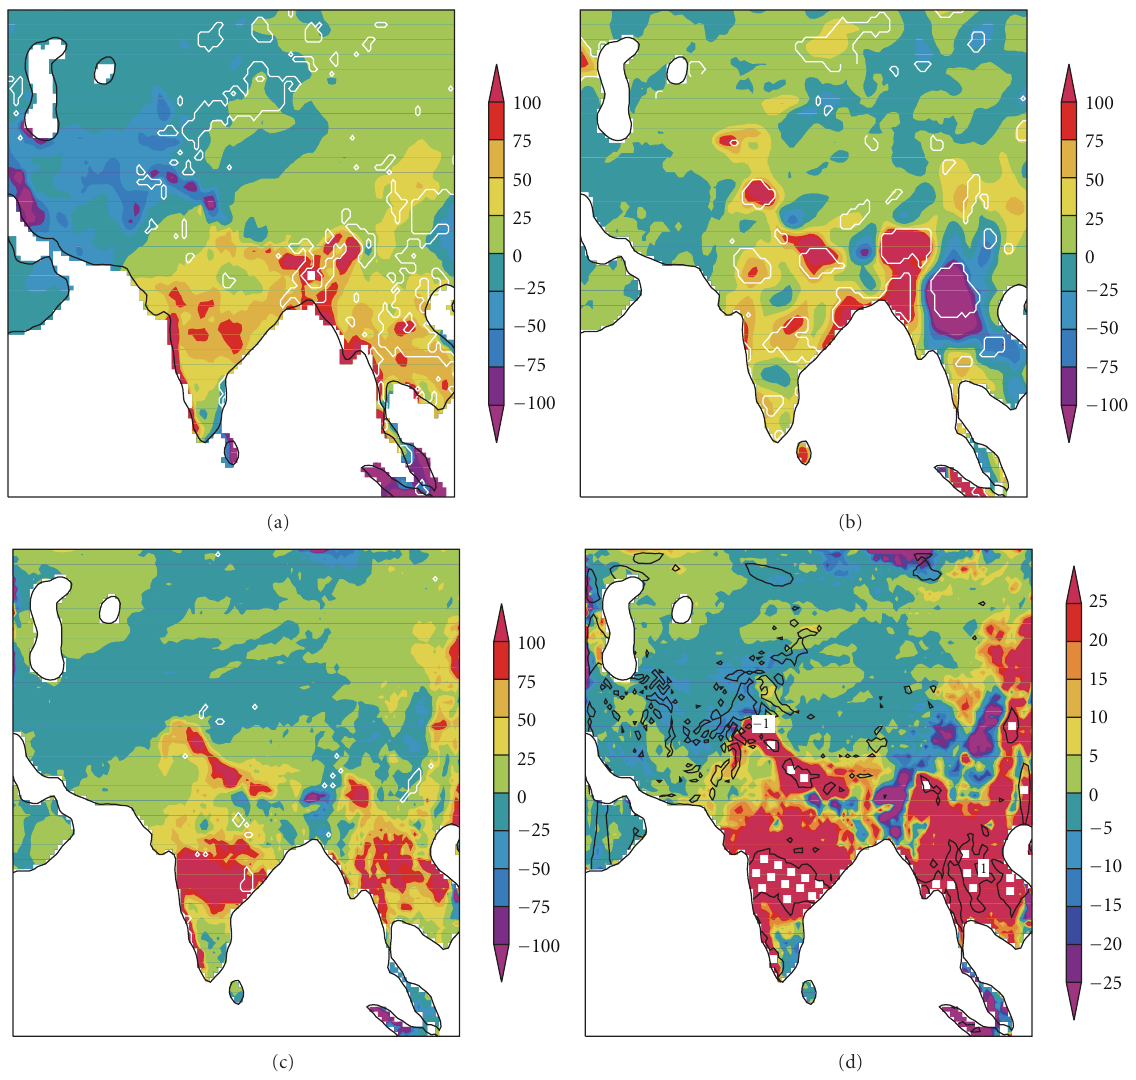
Figure 13: Precipitation “wet-dry” (mm; shaded) and statistical significance (95%; white contour lines) for GPCC4 (a), ERA40 (b), and HIRHAM (c). Precipitation-Evaporation (P-E) “wet-dry” (mm; shaded) and vertical velocity ( ω ) at 500hPa “wet-dry” (hPa/h; black contour lines) for HIRHAM (d); summer monsoon (JJAS) 1958–2001. White dots in (d) show areas with positive anomalies in both P-E and ω